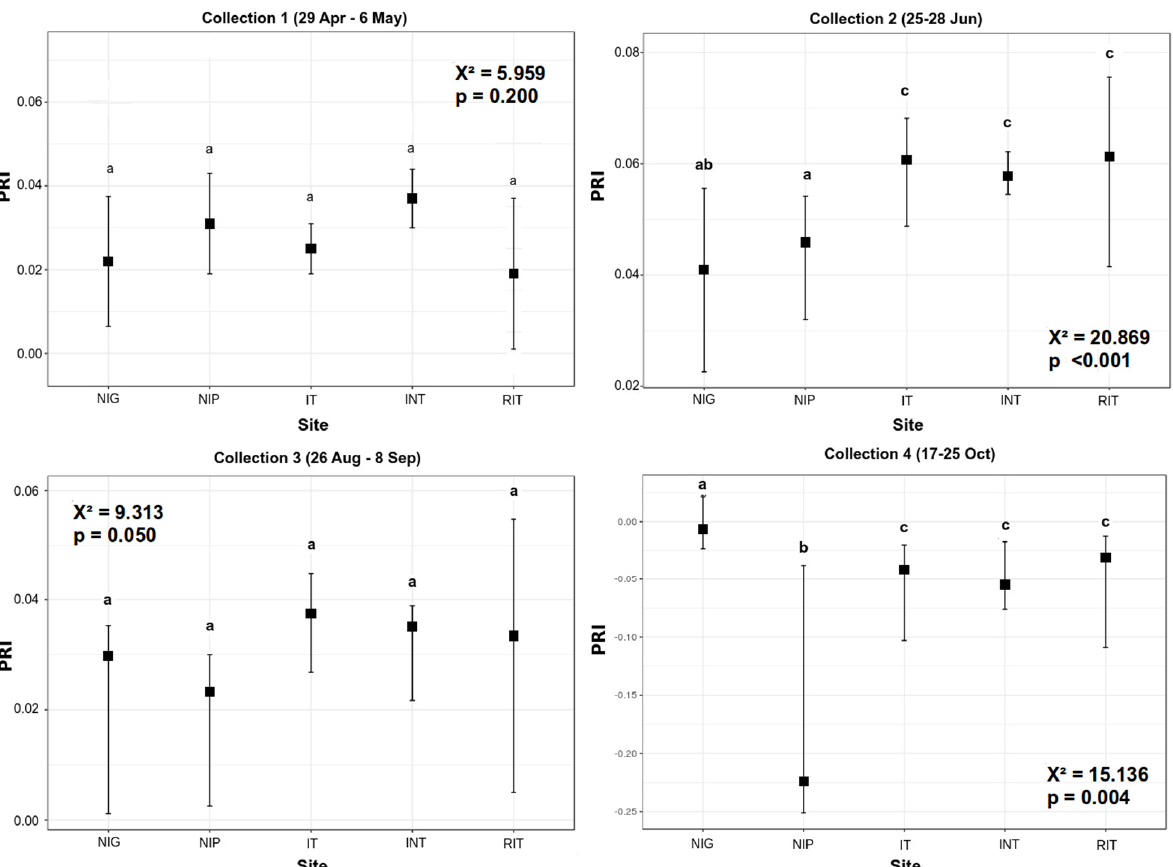
Figure 8. Kruskal–Wallis test results for PRI in 2017. Letters indicate groupings determined by the Conover–Iman test with Bonferroni adjustment. Codes for each site are given in Table 2. Whiskers indicate the range of the data. Note that data ranges were selected to show variation within the data sets, are not uniform between each panel of the diagram.